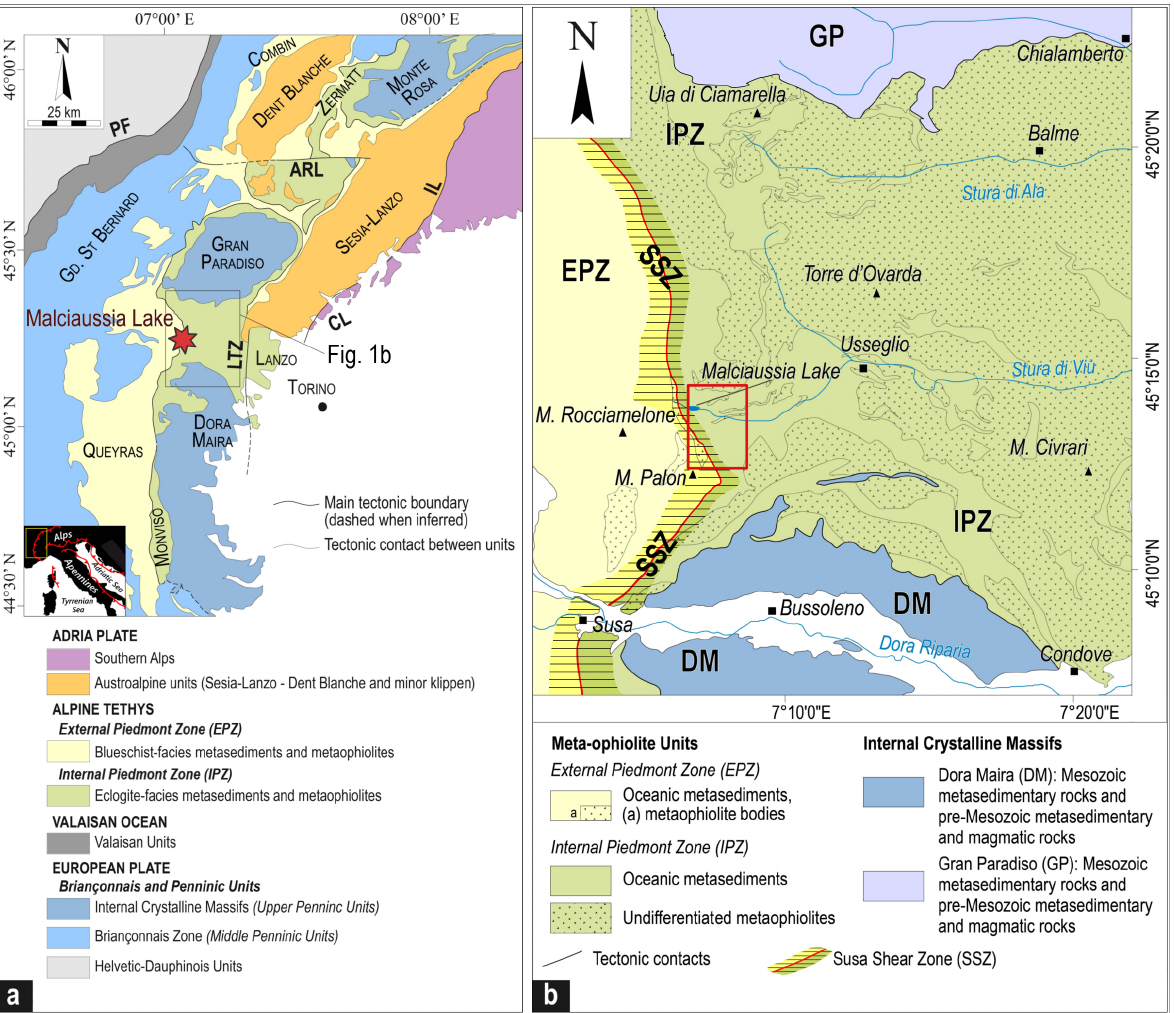
Figure 1. ( a ) Structural map of the Western Alps, modified after Balestro et al. [31]. ARL: Aosta-Ranzola fault, CL: Canavese Line, IL: Insubric Line, LTZ: Lis-Trana Fault Zone, PF: Penninic Front. Black square indicates the location of Figure 1b. ( b ) Structural sketch map of the Stura di Viù Valley area, modified after Nicolas [32], Perotto et al. [33], Bigi et al. [34], Ghignone et al. [35]. Red square indicates the study